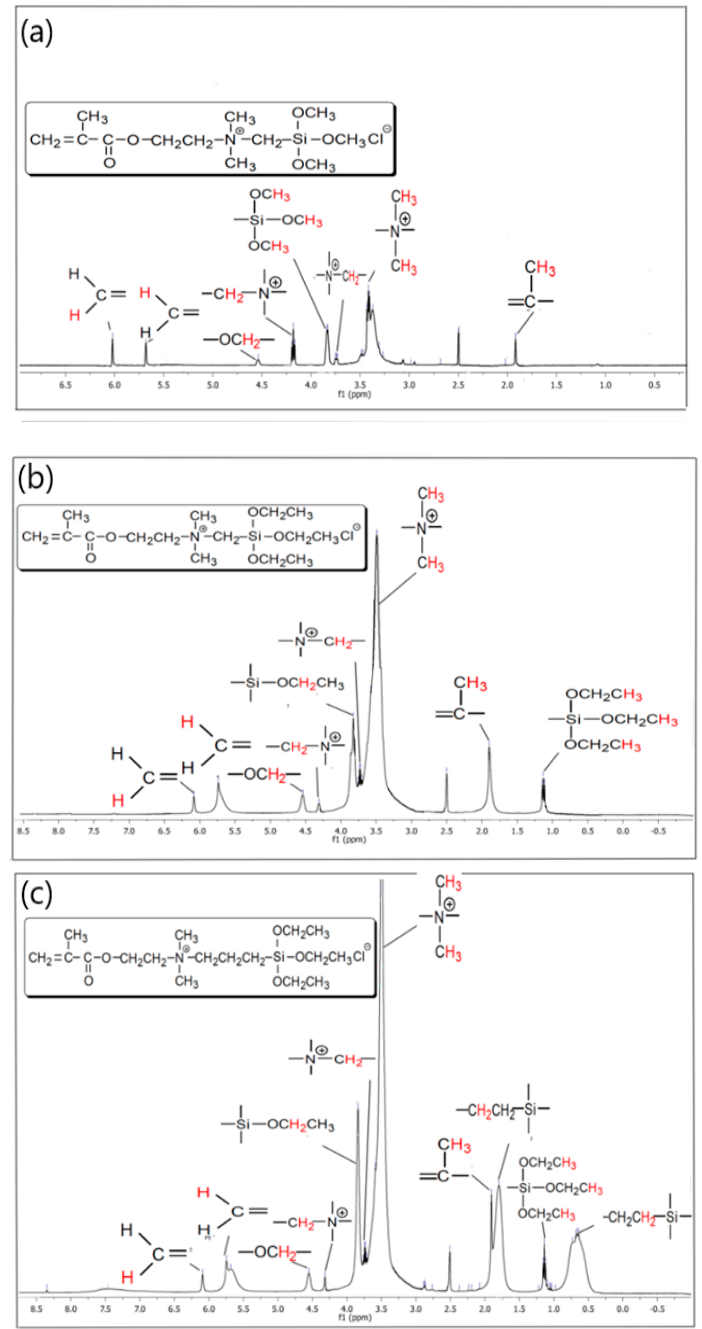
Figure 1. 1 H-NMR spectra of the: ( a ) QAMTMSi; ( b ) QAMTESi; ( c ) QAPTESi organosilanes. The FTIR spectra recorded for the newly synthesized QASiC compounds along with their corresponding starting materials are represented in Figure 2. The absorption peaks at 3020 and 2959 cm − 1 due to =CH and C–H stretch vibrations occurred in all spectra of the obtained products QAMTMSi (Figure 2a), QAMTESi (Figure 2b) and QAPTESi (Fig- ure 2c), denoting the existence of CH, CH 2 and CH 3 groups [59]. The characteristic bands at 2822 and 2771 cm − 1 found in DMAEMA spectrum corresponded to the C–H stretching of (CH 3 ) 2 N– groups. However, these specific bands were not detected in the spectra of the produced organosilanes. The two absorption peaks at 1722 and 1640 cm − 1 observed in all QASiC modifiers were assigned to C=O and C=C stretch vibrations respectively, as a re- sult of the DMAEMA segments contained in their structures. Moreover, the common absorption peaks at 1088 cm − 1 recorded in each QASiC spectrum were attributed to Si–OCH 3 and Si–OCH 2 CH 3 groups coming from CMTMSi (Figure 2a), CMTESi (Figure 2b) and 3CPTESi (Figure 2c) respectively. In each case, Figure 2 disclosed four new bands, namely at 952, 864, 677, and 511 cm − 1 , which could be assigned to the possible formation of new NR 4+ complexes, given that NR 4+ groups are well-known to absorb in the range of 1100–450 cm − 1 [28]. In addition, although the band observed at 690 cm − 1 in the CMTMSi, CMTESi, and 3CPTESi spectra could be assigned to C–Cl bending, it was not detected for the QASiC modifiers any longer. Herein, three new methacrylated quaternary ammonium silanes were synthesized on the basis of the Menschutkin reaction between a tertiary amine-group and an or- gano-halide, also known concerning the high yields of pure products [28,38,41]. Scheme 1 illustrates a modified model of Menschutkin reaction where the DMAEMA played the role of the tertiary amine, whereas the organosilanes CMTMSi, CMTESi, and 3CPTESi could act as organo-halides. As described above, the combination of 1 H-NMR and FTIR findings confirmed the successful synthesis of QAMTMSi, QAMTESi, and QAPTESi or- gano-silanes.